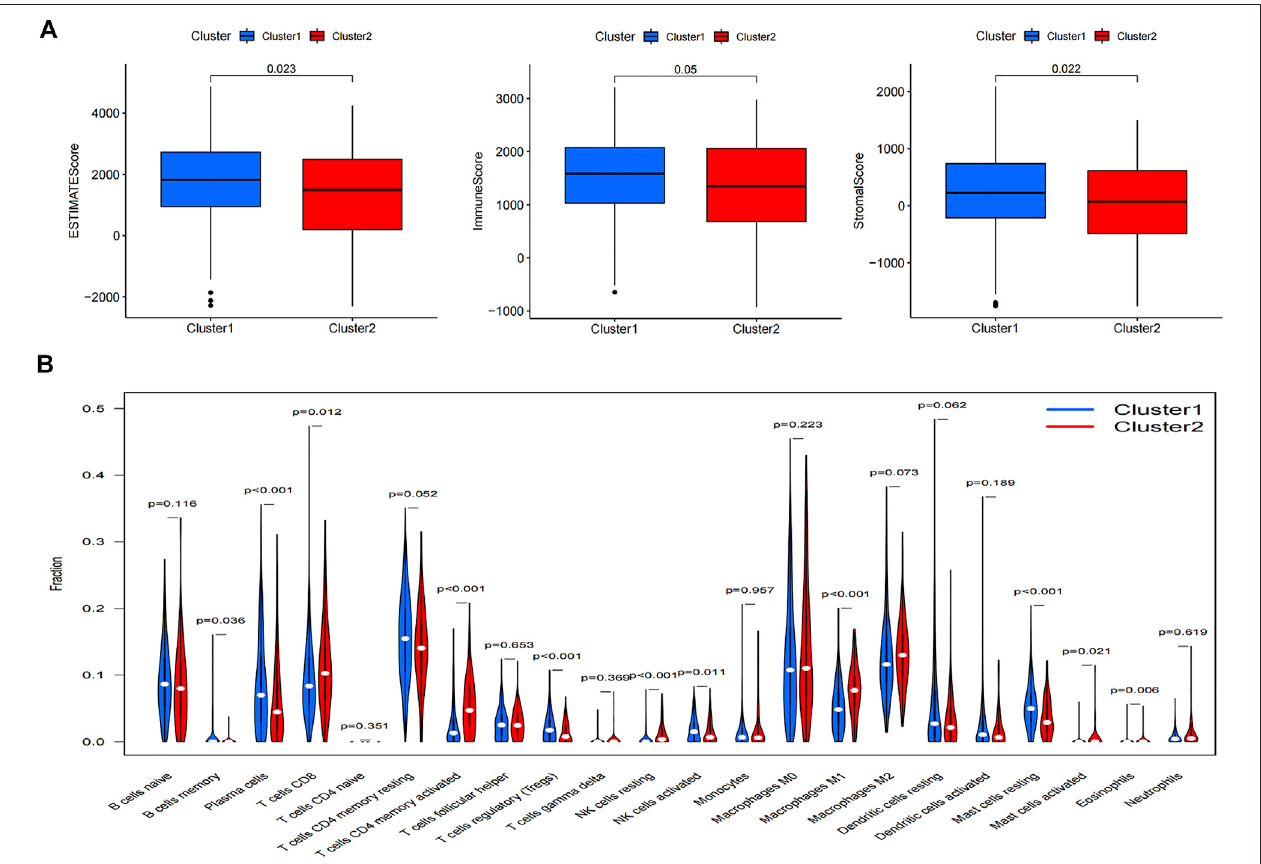
FIGURE 4 | (A) Differences in ESTIMATE, immune, and stromal scores between the two clusters. (B) Differences in levels of in fi ltration between the two clusters.